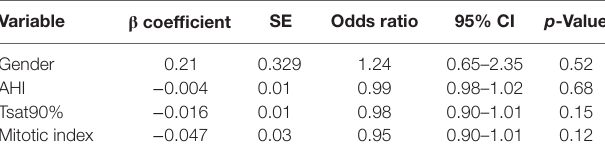
TaBle 3 | Comparisons between expression of vascular endothelial growth factor (VEGF) and general characteristics and aggressiveness markers of melanoma.